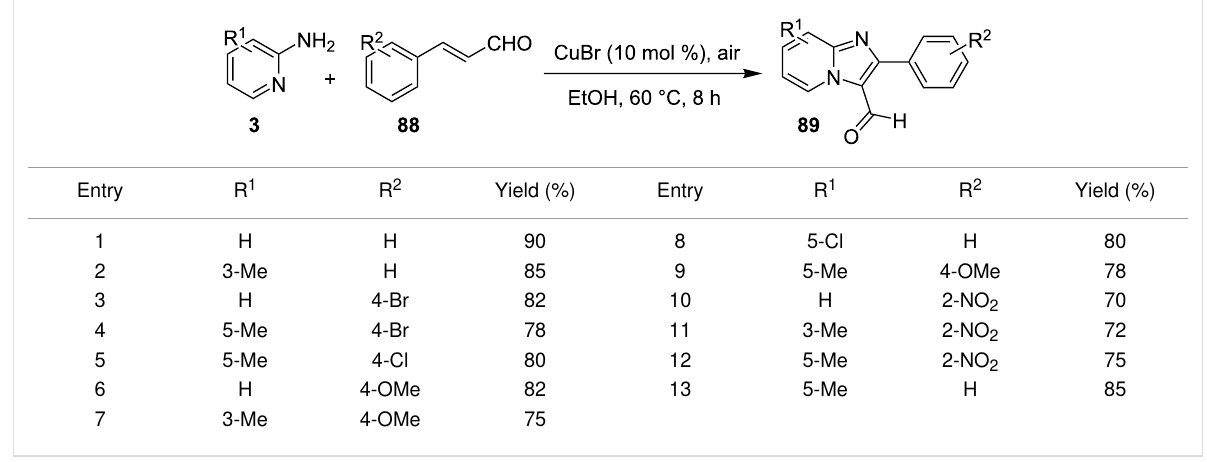
Table 2: Substrate scope for the synthesis of 3-formyl-2-phenylimidazo[1,2- a